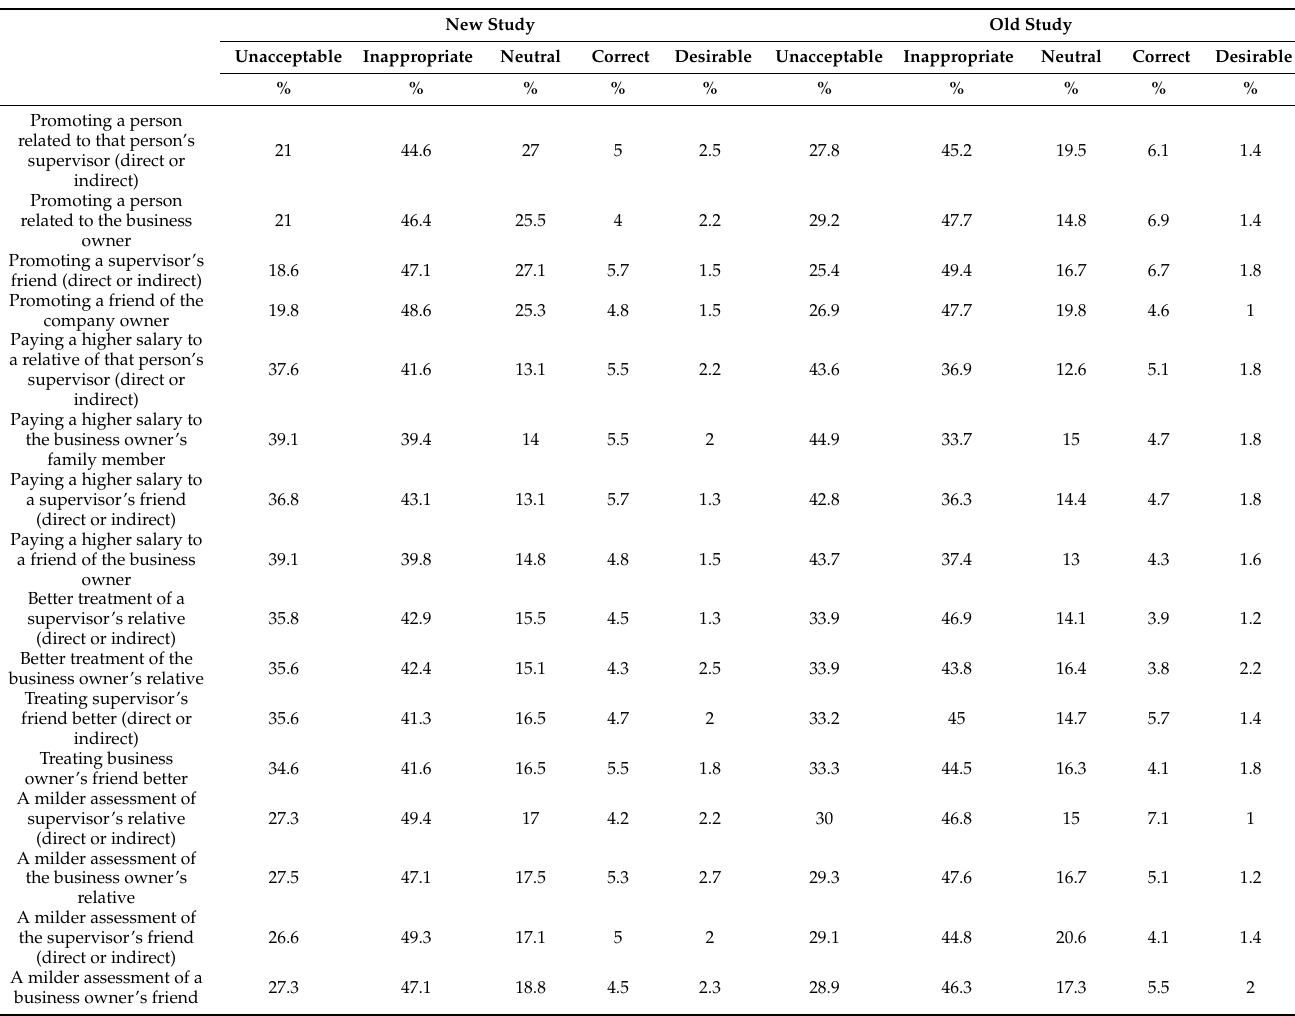
Table 14. Assessment of other situations related to nepotism and cronyism depending on the date of the